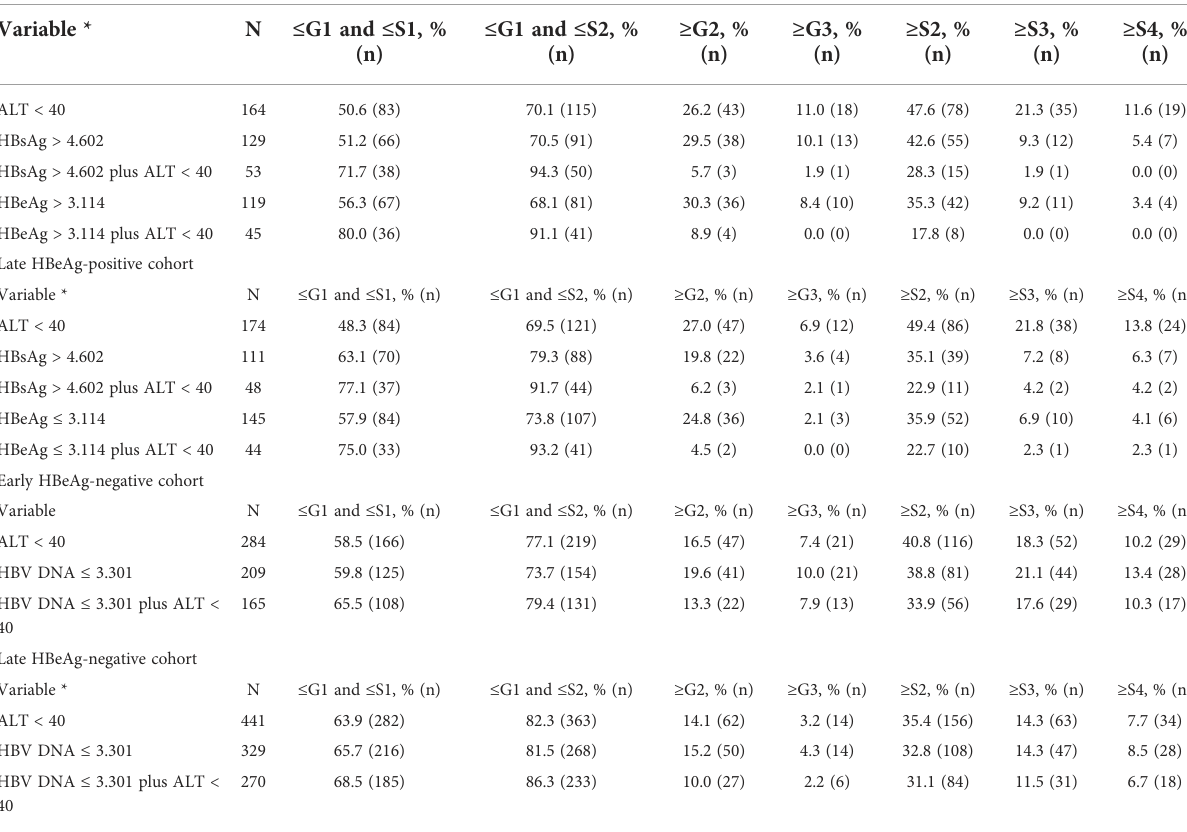
TABLE 5 Proportion of HBsAg, HBeAg, and HBV DNA alone and in tandem with ALT in predicting pathological conditions. Early HBeAg-positive